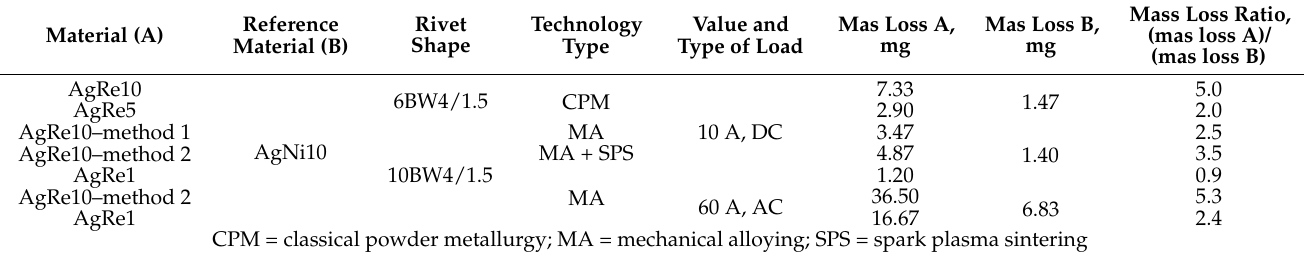
Table 4. Mass loss